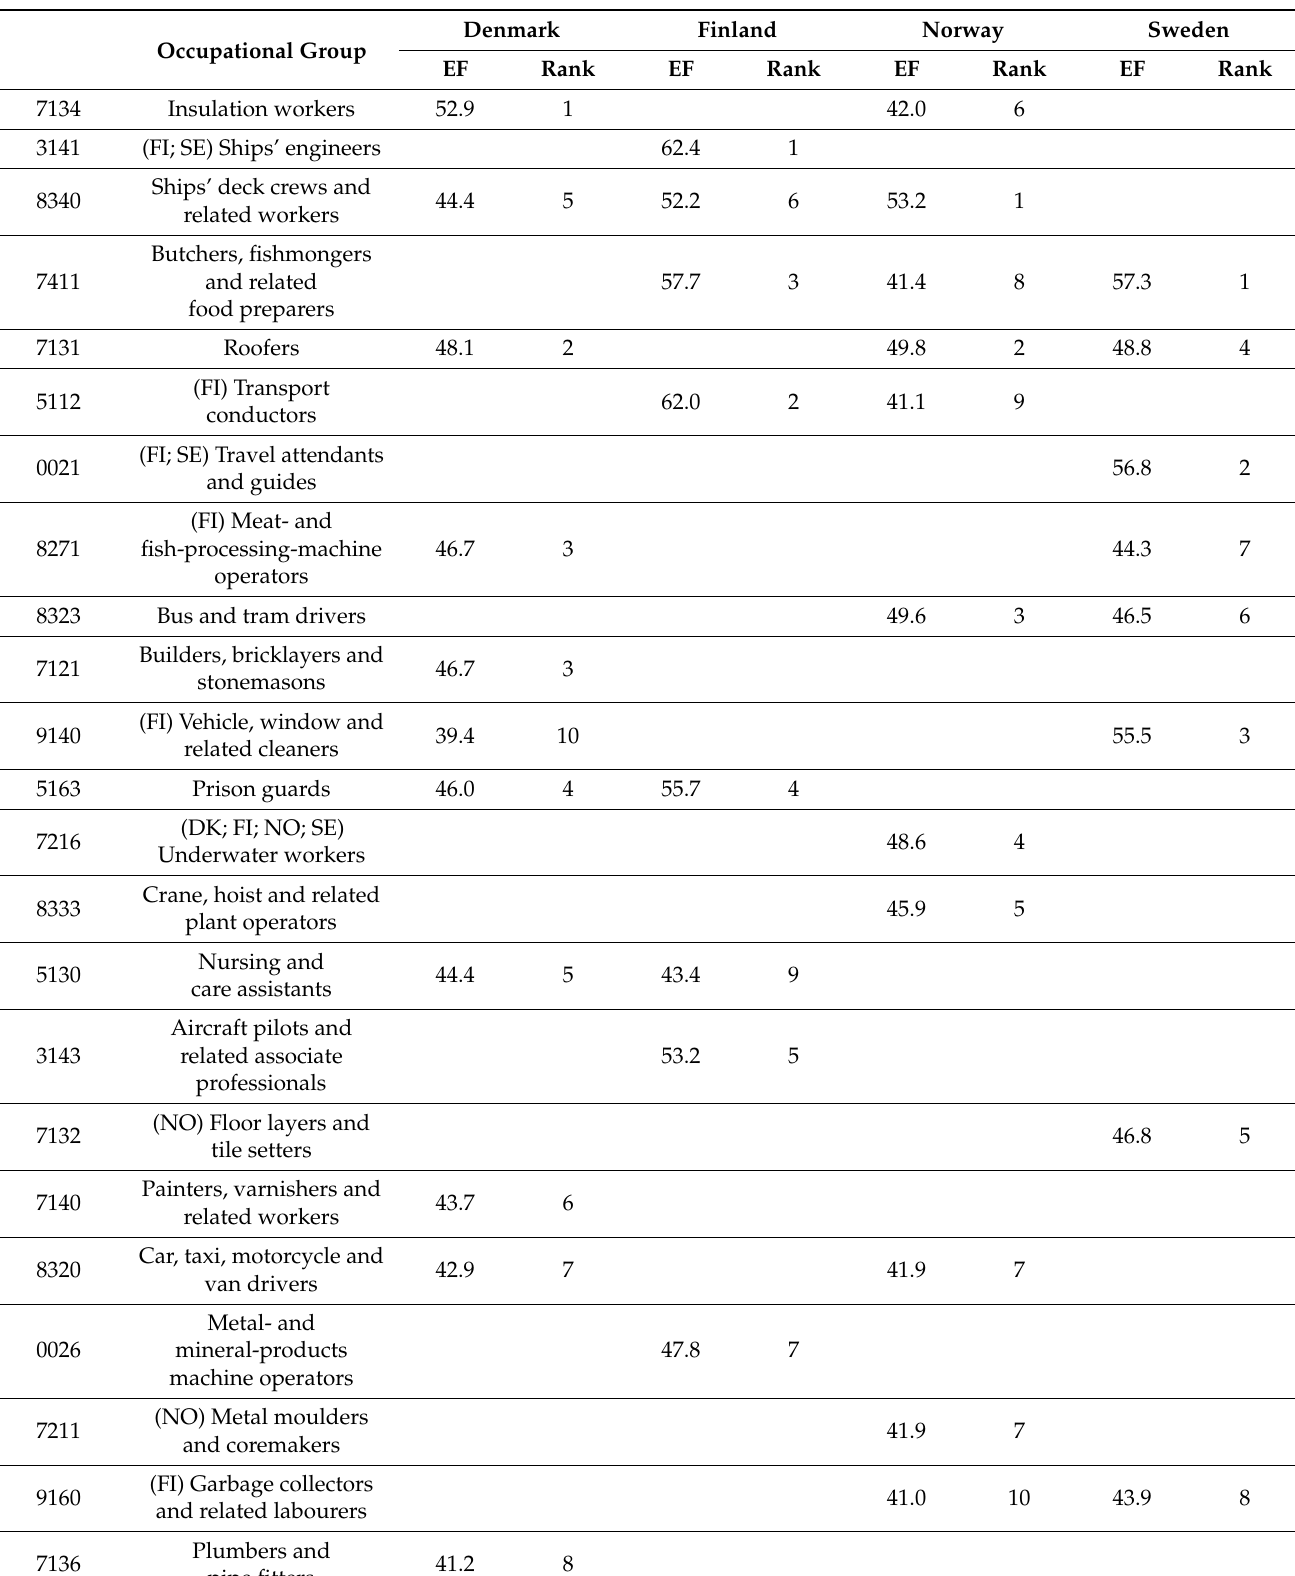
Table 1. Occupational groups with rank 1–10 based on the excess fraction (EF, %) of the age-adjusted one- year cumulative incidence of prolonged all-cause sickness absence among men in four Nordic